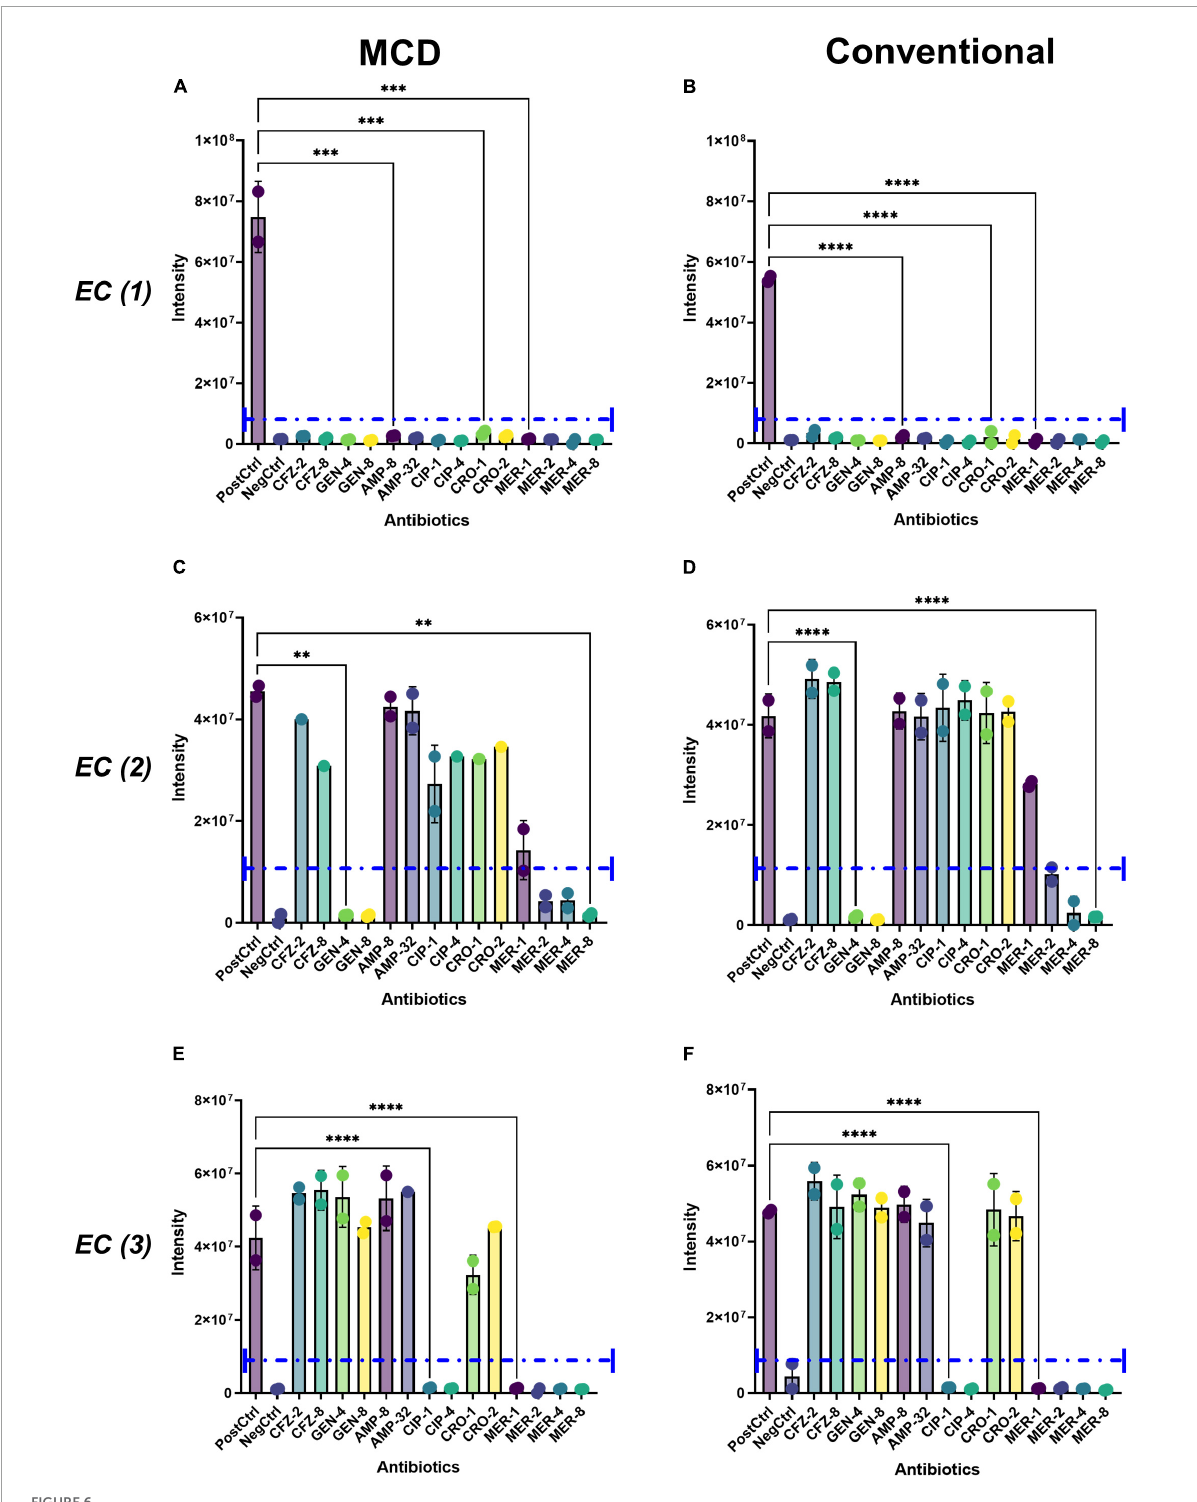
FIGURE6 Demonstration of the MCD as a platform for antibiotic susceptibility testing. The metabolic activity of E. coli (EC, 1, 2, 3) was analyzed when cells were grown in a panel of antibiotics including cefazolin (CFZ 2, 8 µ M), gentamicin (GEN 4, 8 µ M), ampicillin (AMP 8, 32 µ M), ciprofloxacin (CIP 1, 4 µ M), ceftriaxone (CRO 1, 2 µ M), and meropenem (MER 1, 2, 4, 8 µ M). Boundary fluxes were quantified via LC-MS using both the (A,C,E) MCD and (B,D,F) conventional metabolomics workflows. The purple dotted line in each plot shows the signal intensity threshold considered